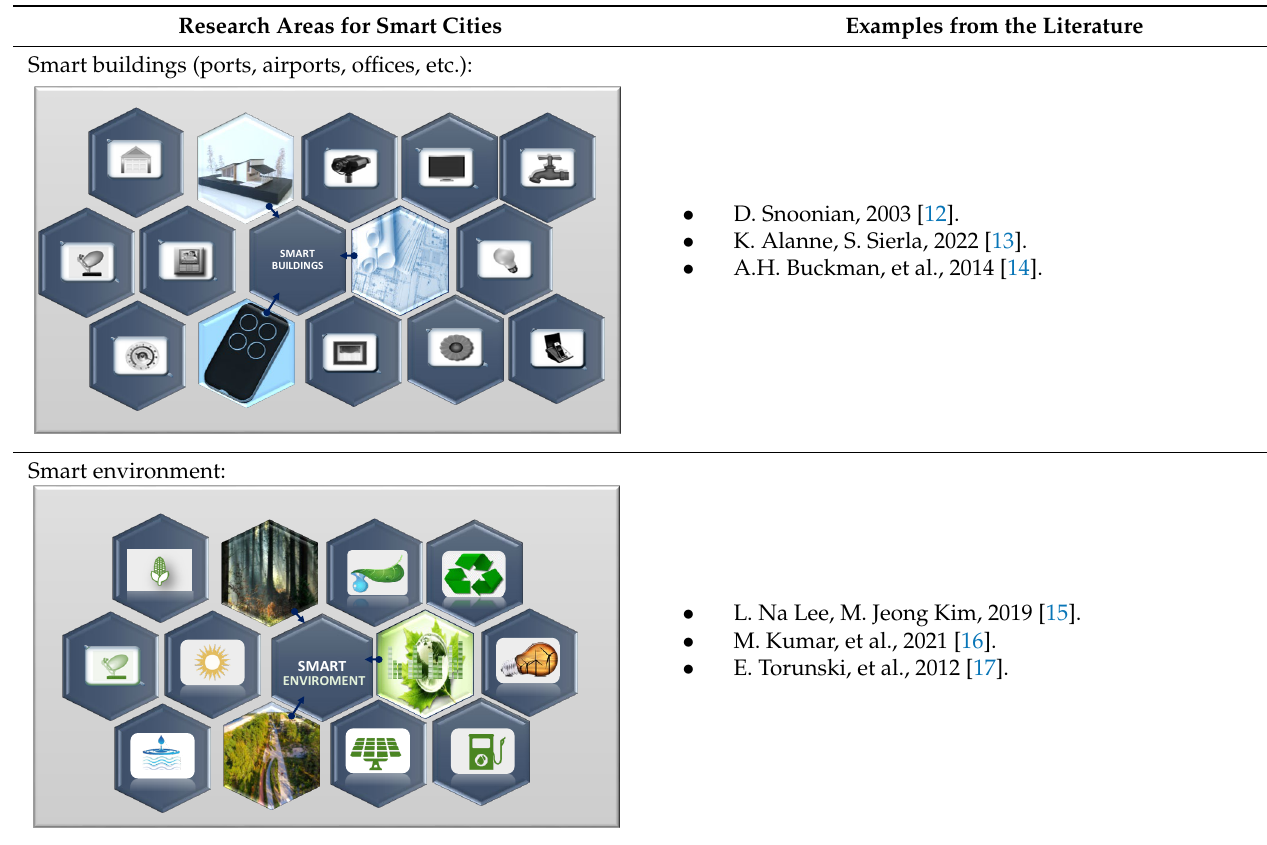
Table 1. Smart city research areas.